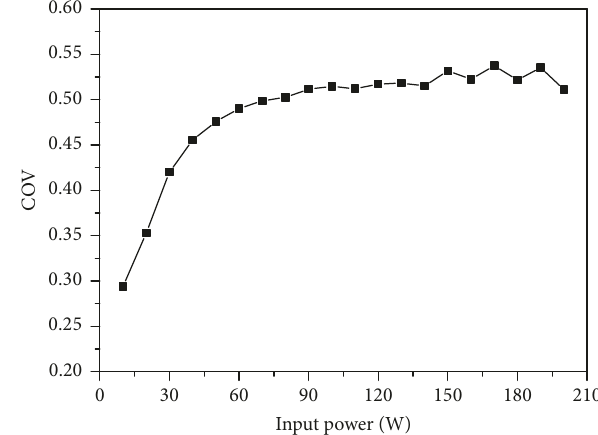
Figure 5: Energy consumption of different input power.